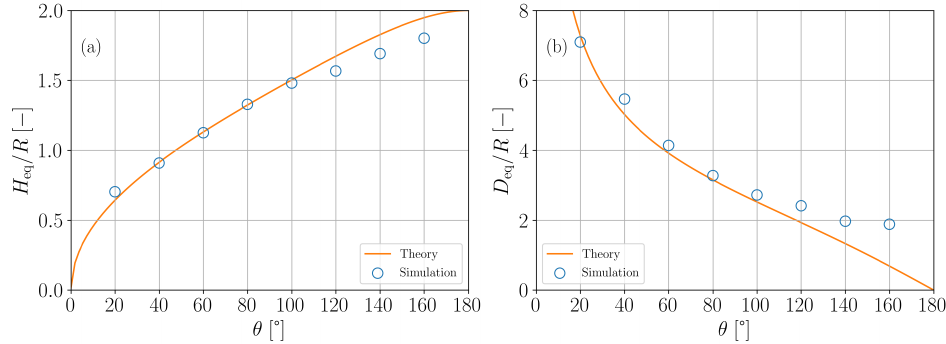
Figure 10. Comparison of simulation results and theory for the wetting of a planar substrate. ( a ) Normalized droplet height as a function of contact angle parameter. ( b ) Normalized droplet base diameter as a function of contact angle parameter.